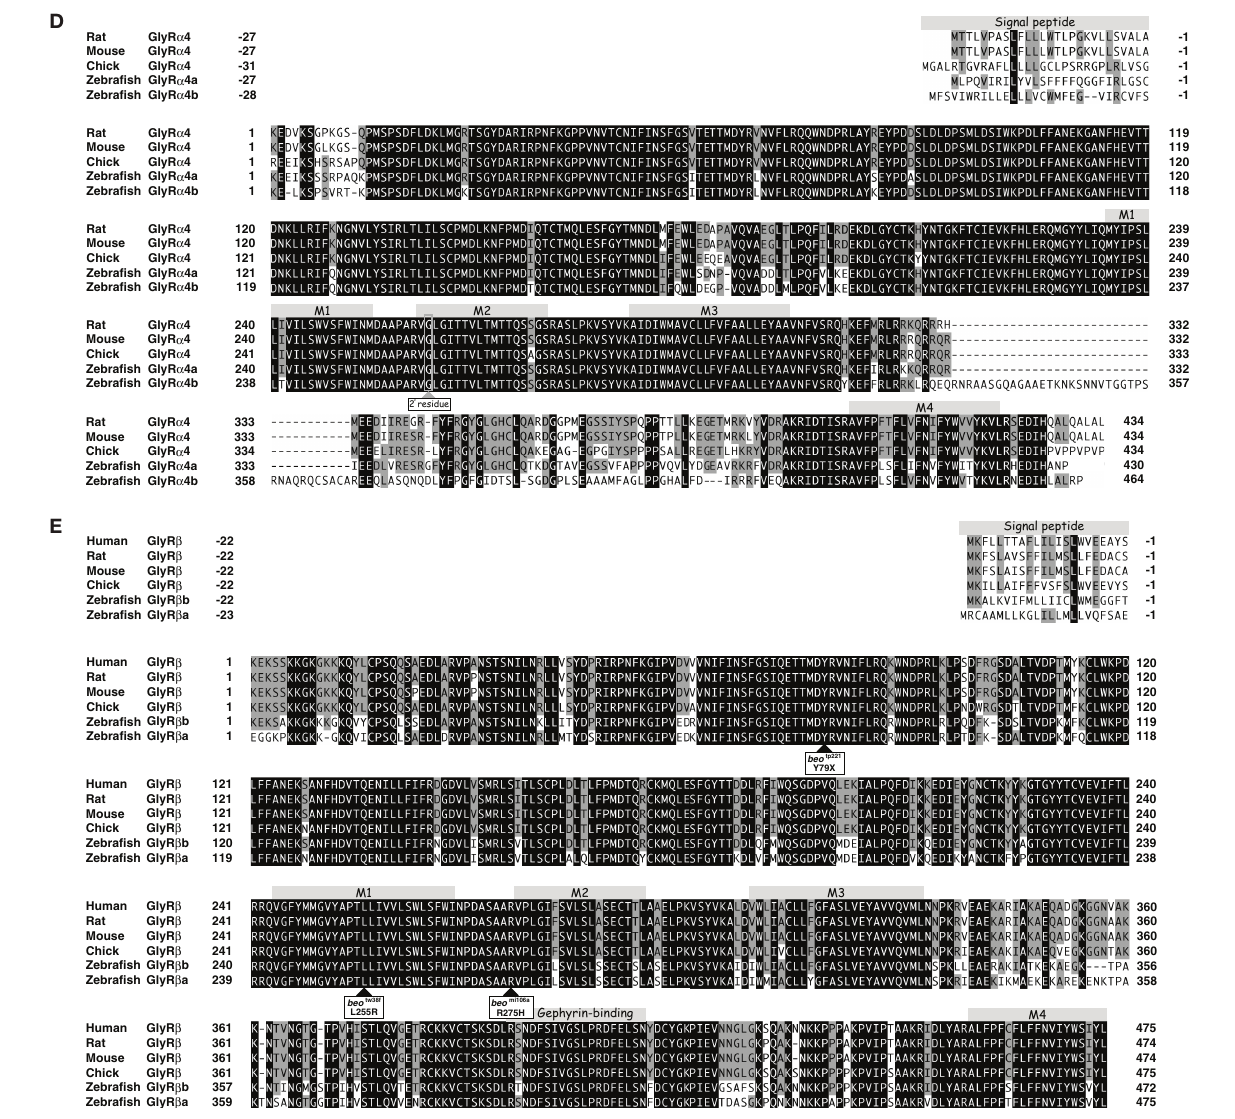
alignment of human (NP_000815), rat (NP_445748), mouse (NP_034428) and chick (XP_420379) GlyR β with zebrafi sh GlyR β b (NP_001003587) and GlyR β a (XP_683646). Position of mutations identifi ed in the three beo alleles are represented by